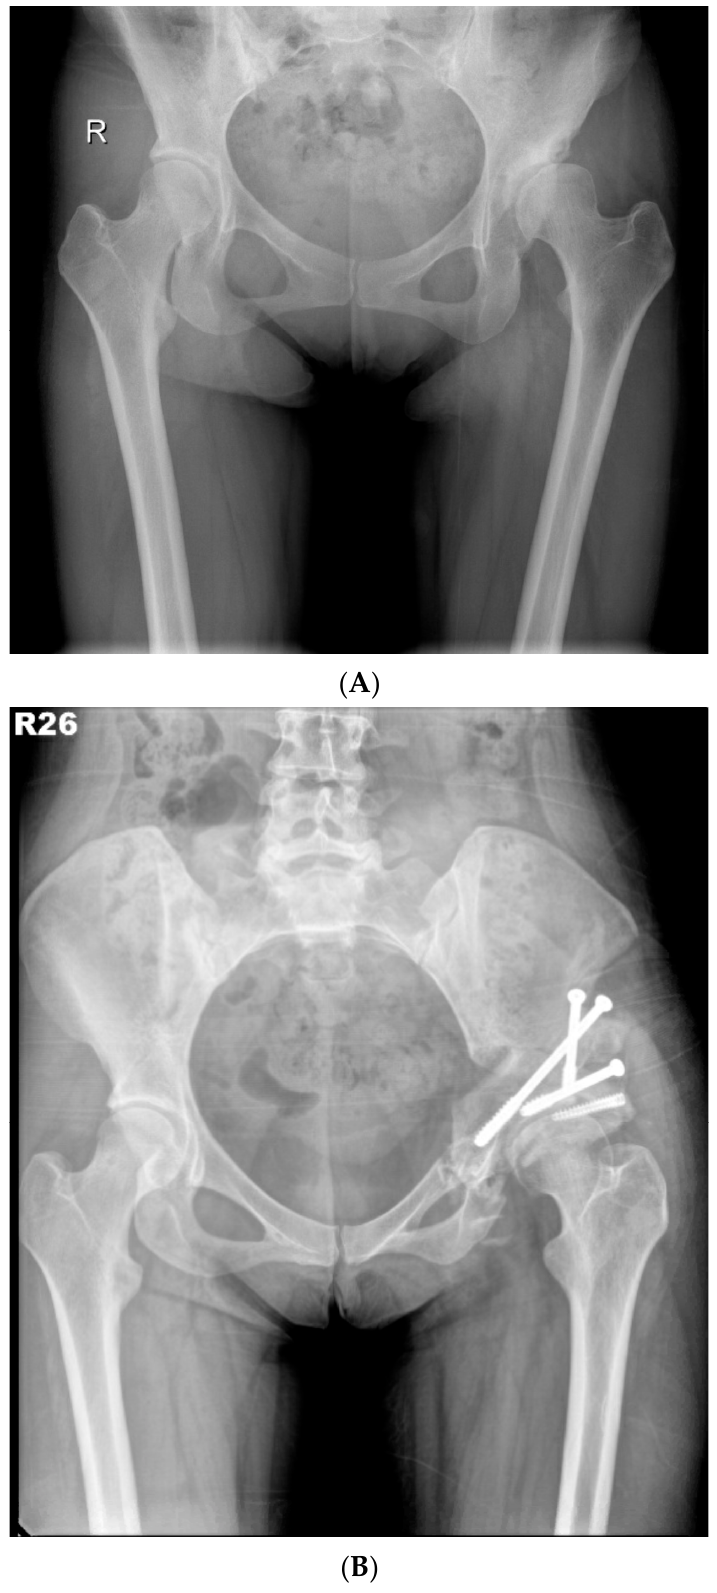
Figure 2. ( A ) Preoperative anteroposterior standing radiograph of a 26-year-old woman who underwent MTI osteotomy for symptomatic left hip dysplasia. ( B ) Postoperative anteroposterior standing radiograph showed good coverage of the femoral head.